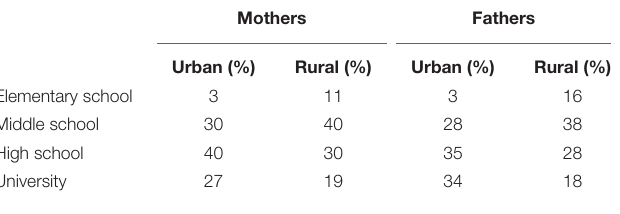
TABLE 1 | Education level of the parents in urban and rural areas (percentages).